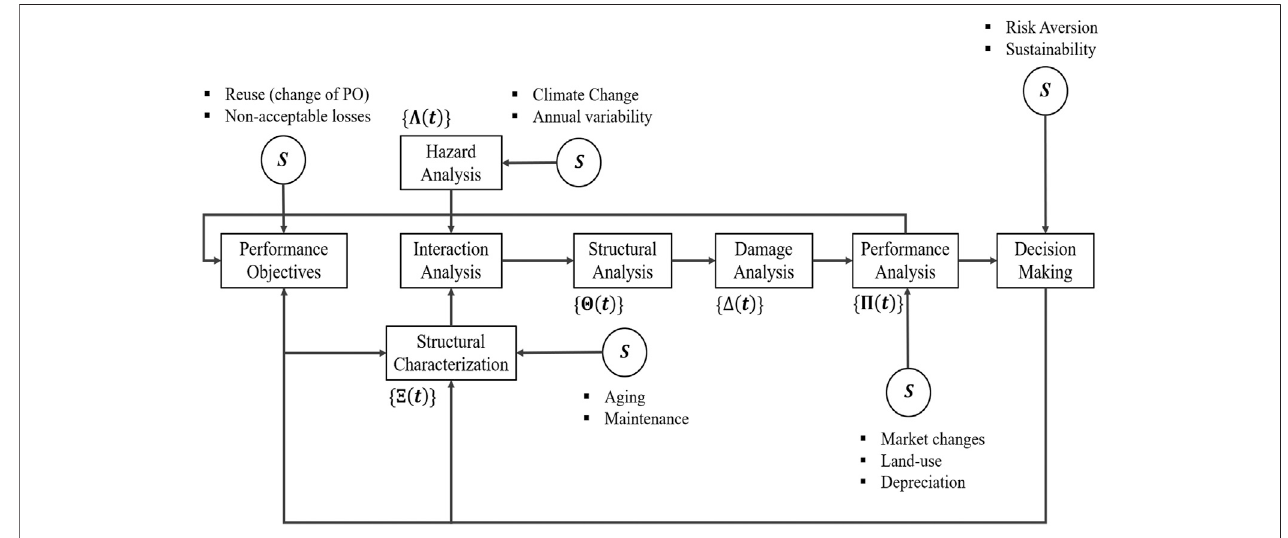
FIGURE1| Proposed Performance-Based CoastalEngineering(PBCE)framework.Theframeworkconsists ofsixbasiccomponents: (1)performance objectives, (2) hazard analysis, (3) structural characterization, (4) structural analysis, (5) damage analysis, and (6) performance analysis.